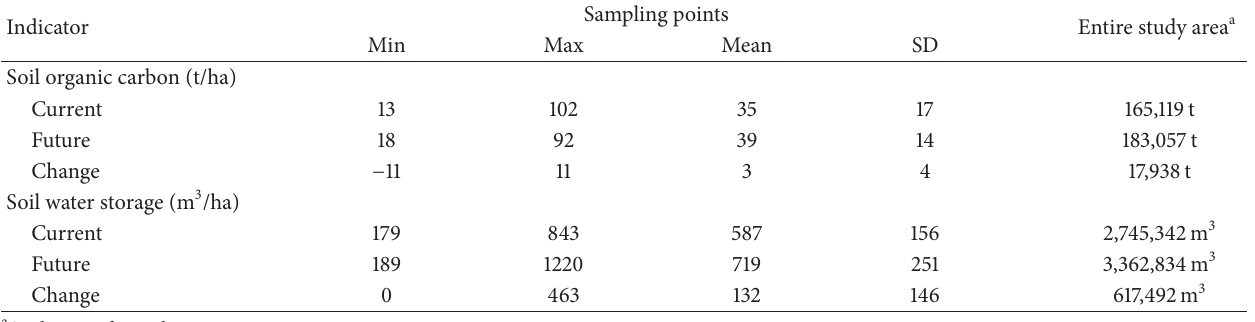
Table 3: Estimates of service indicator at 60 sampling points (0–30 cm depth) and over the entire study area, under current and future (25- year) land-use scenarios. Overall changes in each indicator were based on differences between supply on an average day under the current scenario and on an average day in 25-year-time under the future scenario.